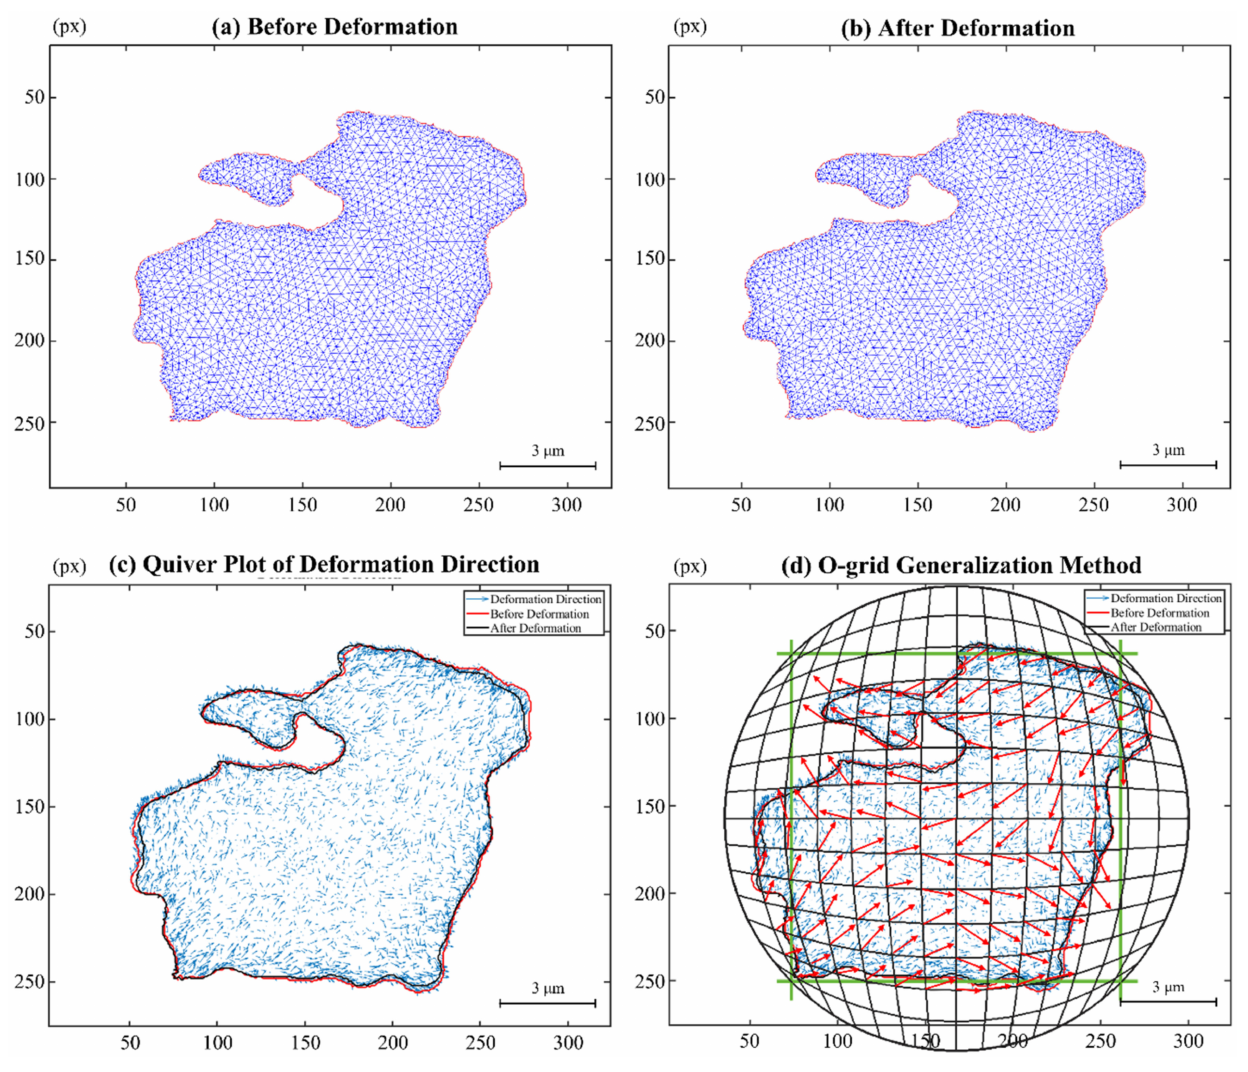
Figure 14. Implementation of the integrated toolsets for extracting the direction of grain deformation: ( a ) geometric meshing analysis on grain before deformation, ( b ) geometric meshing analysis on grain after deformation, ( c ) quiver plot of direction of metal grain deformation, and ( d ) O-grid generalization method to amplify the trend of direction